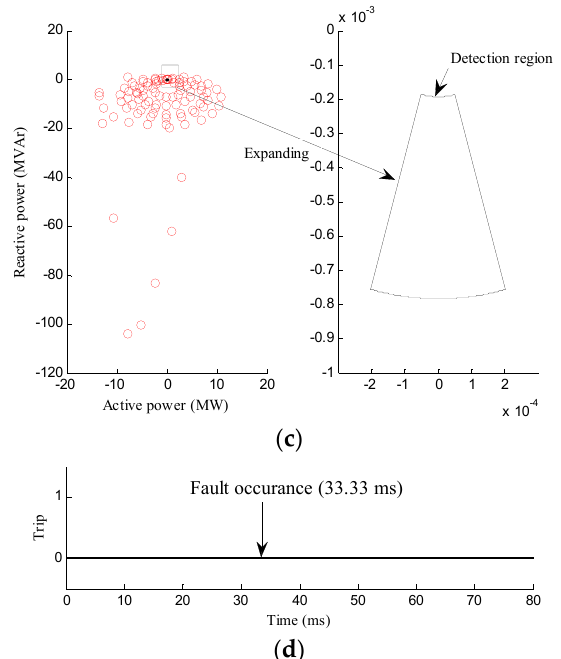
Figure 11. Results for Case 9. ( a ) v a , b , c (upper) and i a , b , c (lower); ( b ) p 3 ph (upper) and q 3 ph (lower); ( c ) Trajectories of the point ( p 3 ph , q 3 ph ); ( d ) Islanding detection signal.